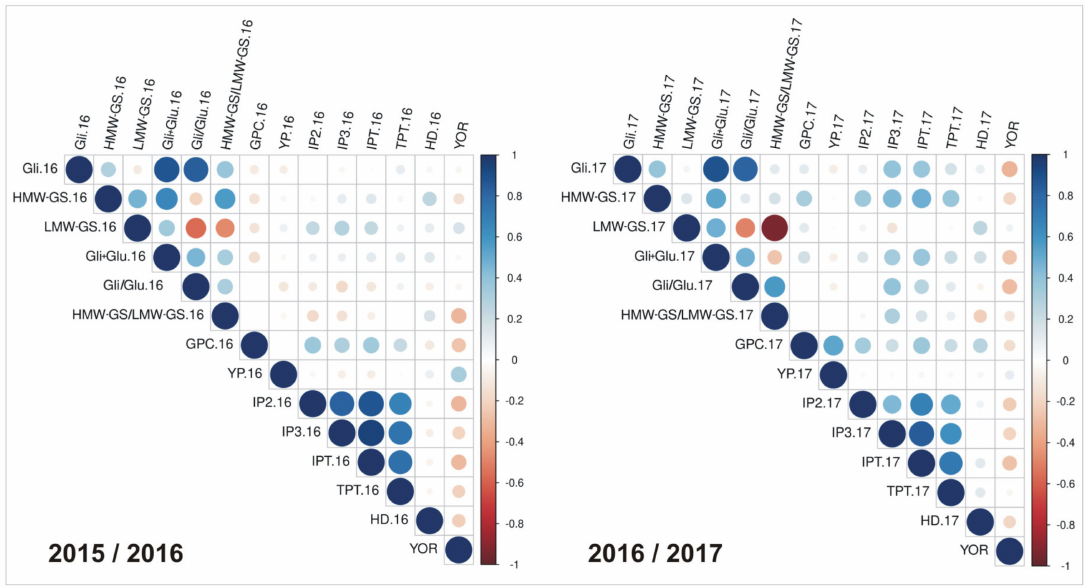
Figure 3. Pearson’s rank correlation coe ffi cients between pairs of traits measured in 2015 / 2016 and in 2016 / 2017 cropping seasons. Positive correlations are in blue and negative correlations in red. Color intensity (from light to dark) and the size of the circles (from small to big) are proportional to the correlation coe ffi cients. GPC = grain protein content; Gli = gliadins; Glu = glutenins; HMW-GS = high molecular weight glutenin subunit; LMW-GS = low molecular weight glutenin subunit; YP = yellow pigment; IP = immunogenic peptide(s) and total (IPT); TPT = toxic peptide total; HD = heading date; YOR = year of